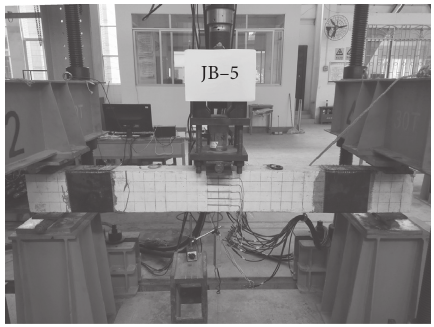
Figure 3: Loading test device